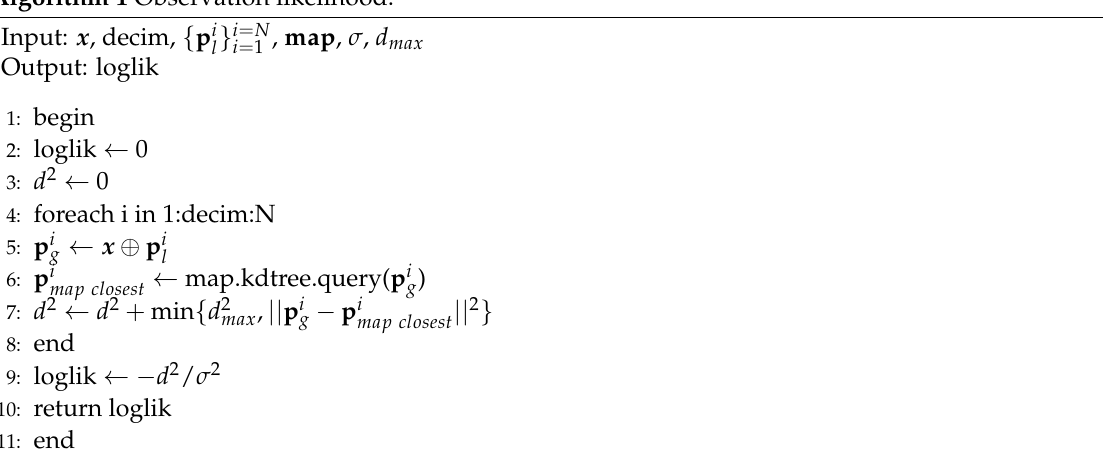
Algorithm 1 Observation